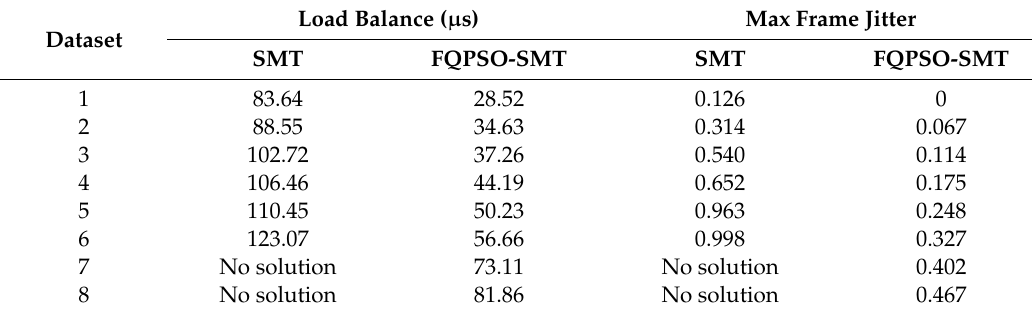
Table 7. Load balance and jitter